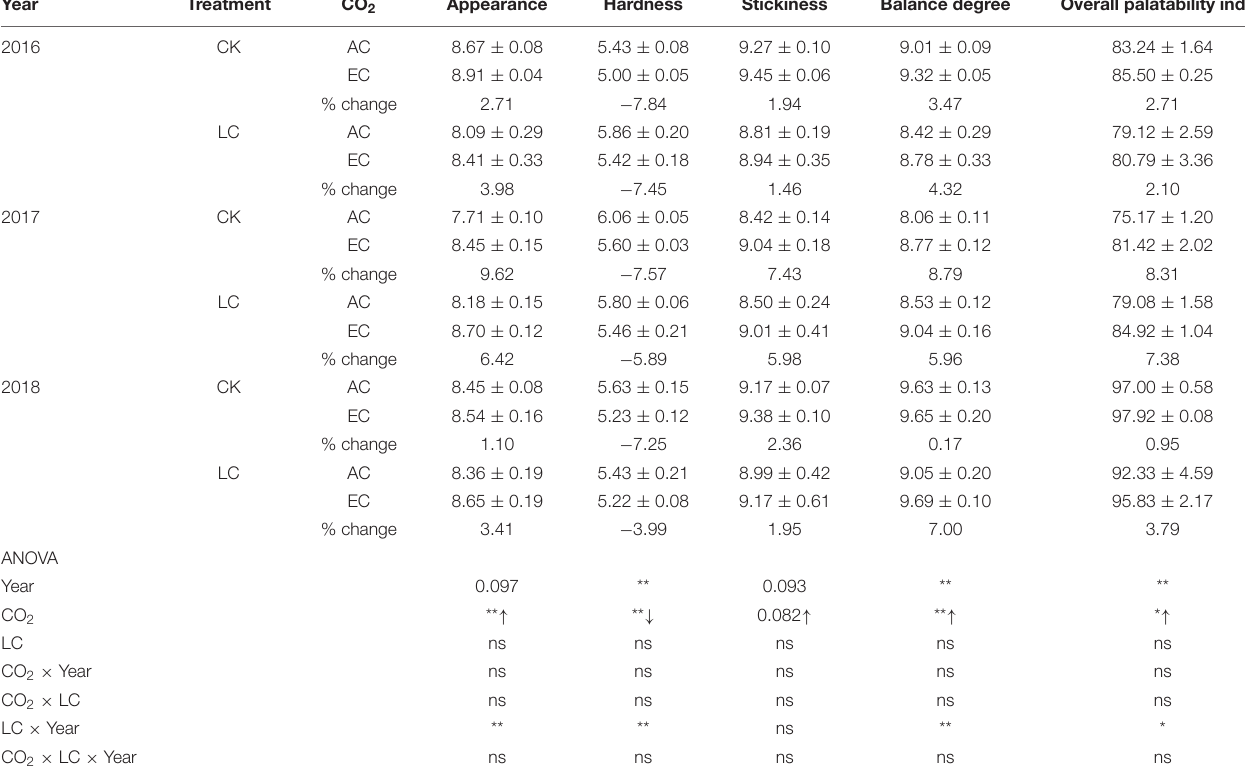
TABLE 4 | Effect of elevated CO 2 and cutting off top three leaves (LC) on the taste of cooked milled rice across three cropping seasons (2016–2018). Year Treatment CO 2 Appearance Hardness Stickiness Balance